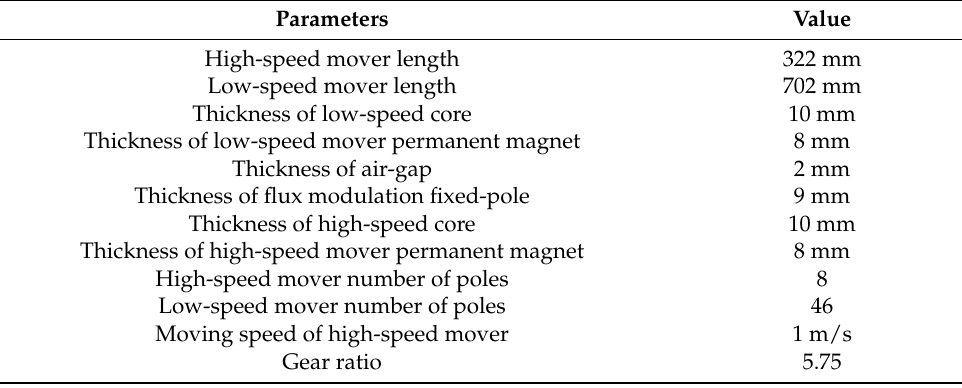
Table 1. Design specifications of the linear magnetic